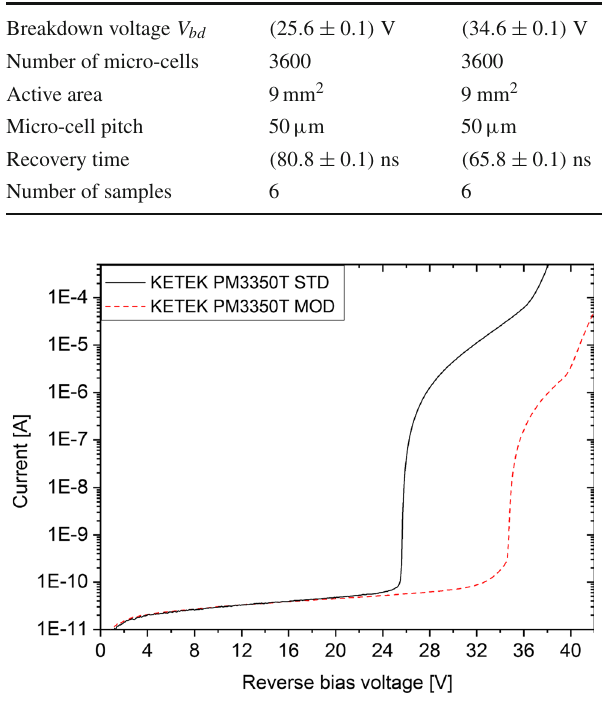
Fig. 4 Current-voltage characteristics of the KETEK PM3350T STD and the PM3350T MOD at dark